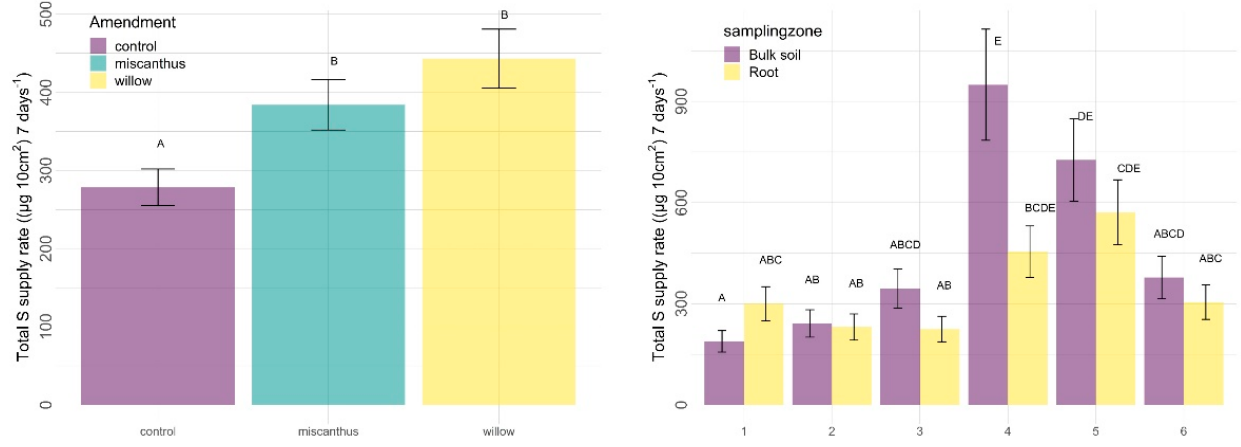
Figure 11. S supply rates as a function of amendment ( left ) and interaction between sampling zone and time ( right ). Different letters indicate significance at p < 0.05 using the post hoc Tukey HSD test.